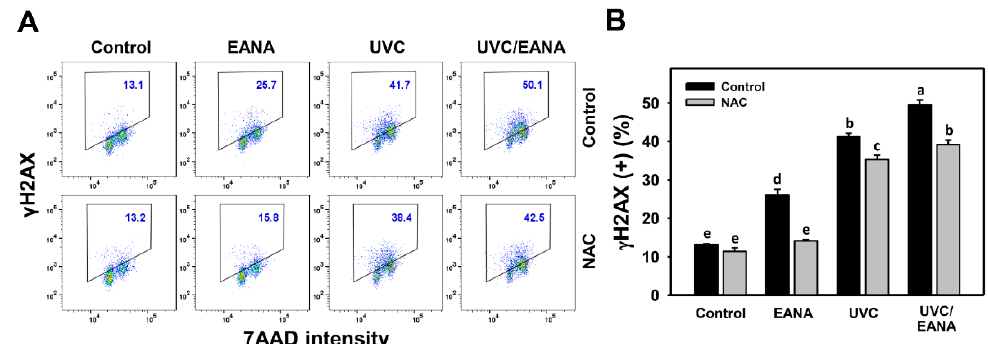
Figure 8. γH2AX analyses of EANA and/or UV treatments for human oral cancer Ca9-22 cells. With or without NAC (10 mM) pretreatment for 1 h, cells were post-treated with control (DMSO only), EANA (5 µg/mL), UVC (12 J/m 2 ), and combined treatment (UVC/EANA) for 24 h. ( A ) Typical flow cytometry patterns for γH2AX content. γH2AX intensity-positive regions were marked with a box. ( B ) Statistical analysis for (A). Treatments showing no overlapping labels (a–e) differ significantly between multiple comparisons ( p < 0.01–0.0001). Data, mean ± SD ( n = 3).